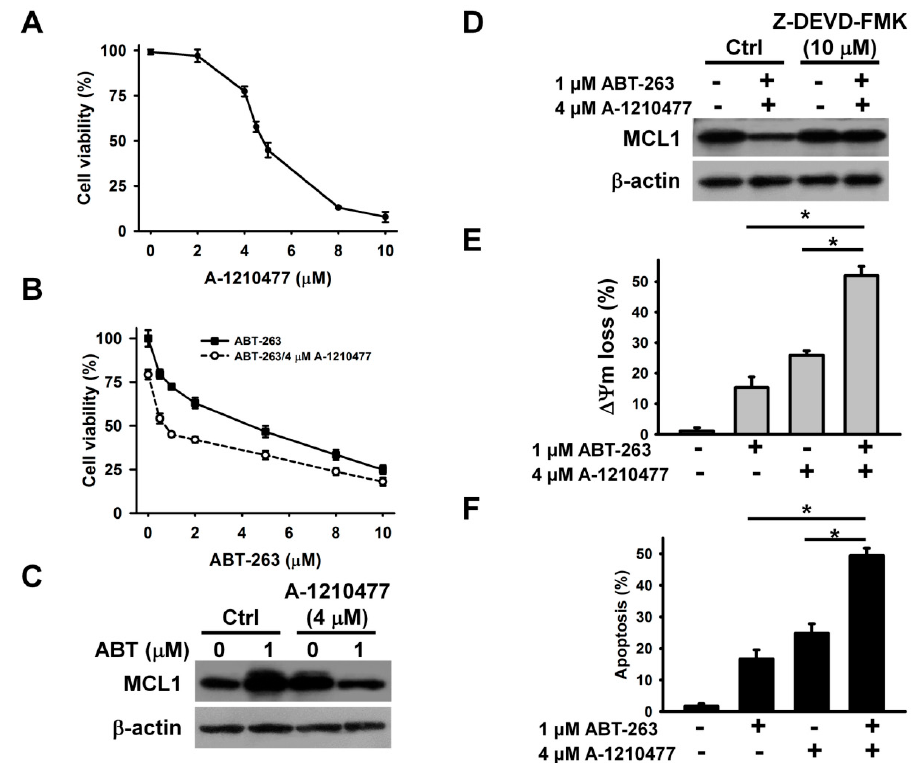
Figure 3. A-1210477 enhanced the cytotoxicity of ABT-263. ( A ) The cytotoxicity of A-1210477 on K562 cells. K562 cells were treated with indicated A-1210477 concentrations for 24 h. ( B ) E ff ect of A-1210477 on the cytotoxicity of ABT-263 on K562 cells. K562 cells were treated with 4 µ M A-1210477 and indicated ABT-263 concentrations for 24 h. ( C ) Western blot analyses of MCL1 expression in A-1210477-, ABT-263-, and A-1210477 / ABT-263-treated cells. K562 cells were treated with 1 µ M ABT-263 and / or 4 µ M A-1210477 for 24 h. ( D ) E ff ect of caspase-3 inhibitor on MCL1 expression in A-1210477 / ABT-263-treated cells. K562 cells were pretreated with 10 µ M Z-DEVD-FMK for 1 h, and then incubated with ABT-263 plus A-1210477 for 24 h. ( E ) E ff ect of A-1210477, ABT-263, or A-1210477 / ABT-263 on ∆Ψ m in K562 cells. ( F ) E ff ect of A-1210477, ABT-263, or A-1210477 / ABT-263 on apoptosis induction in K562 cells. Apoptosis was assessed in triplicate by annexin V-PI double staining followed by flow cytometry, and percentage apoptosis is shown as percentage of annexin V-positive cells. Data represent mean ± SD ( * p < 0.05).